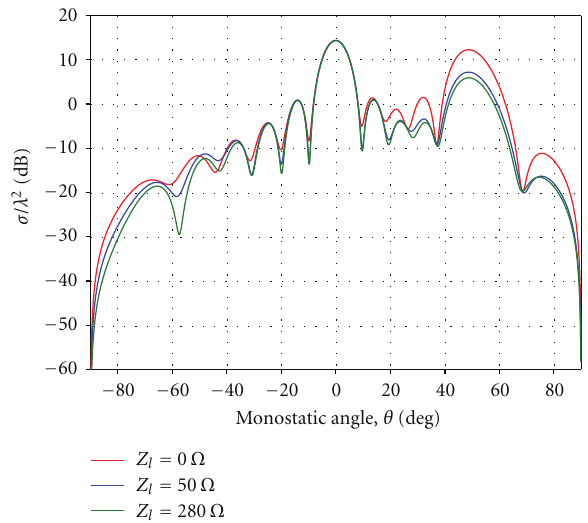
Figure 24: E ff ect of terminating impedance on RCS of series-fed linear array including mutual coupling e ff ect. N = 30, “ θ s = 50 ◦ ”, ψ = π/ 2, l = 0 . 5 λ , d = 0 . 1 λ , a = 10 − 5 λ , and Z Dolph-Chebyshev distribution for side-by-side